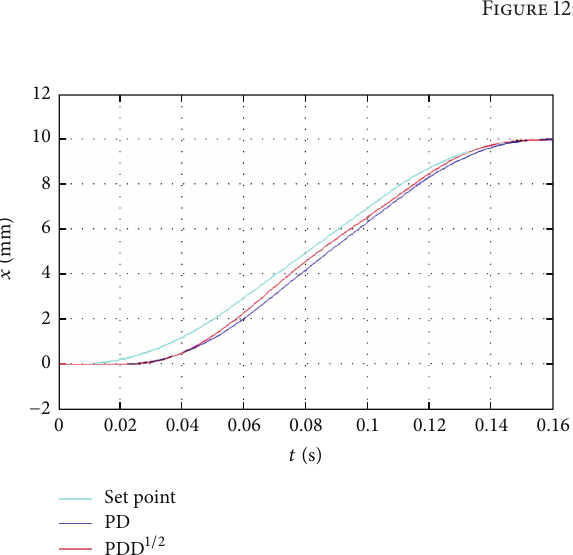
Figure 12: Control scheme.